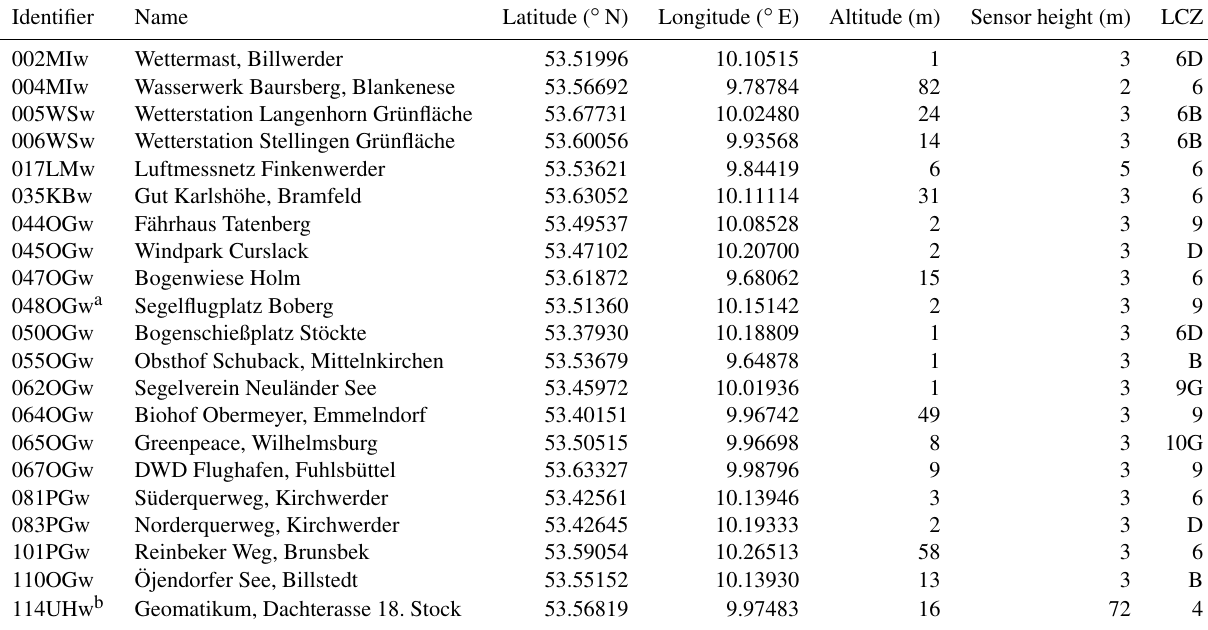
Table 4. As Table 3, but for WXT measurement sites.